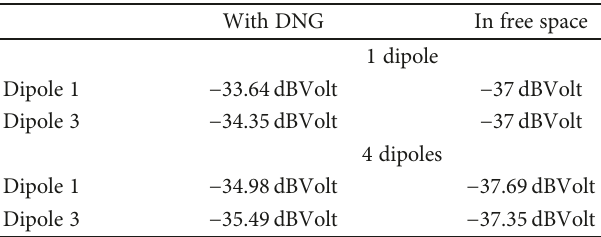
Figure 10: Absolute values of the voltage induced at the open input terminal of dipoles with DNG and free space (a) only one dipole (1 or 3) and (b) all 4 dipoles present, results for 1 and 3. DoA: Table 1: V values at the open-circuited input terminals of the ocave dipoles. Average values over the UMTS band. DoA: 0deg.